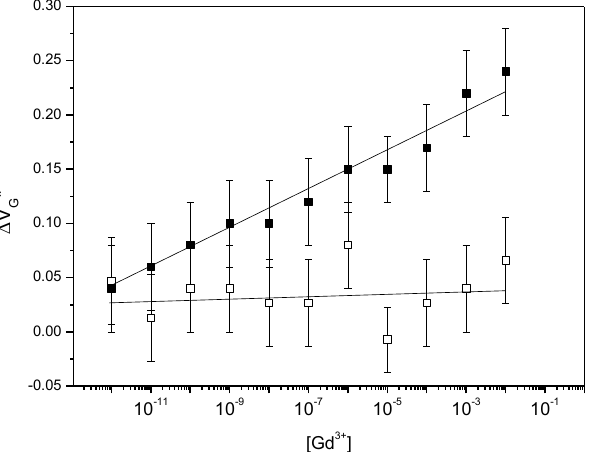
Figure 5. Position of the minimum of the transfer curve for various Gd 3+ or Ca 2+ concentrations, on a DO3A-alkyne functionalized EGGFET in an electrolyte containing Ni 2+ , Ca 2+ , Na + and In 3+ ions at 10 −6 M each + 0.1 M KCl (black squares) and for various Ca 2+ (white squares) in an electrolyte containing 0.1 M KCl.